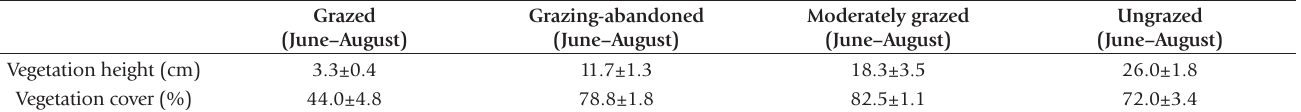
Fig. 3. PCoA ordination (sum of all eigenvalues: 20.008, similarity index: correlation) based on Orthoptera data. The different years are marked by A, B, C, D and E ( A : 2012, B : 2013, C : 2014, D : 2015 and E : 2016; e.g. 1-A : site 1 in 2012, 2-B : site 2 in 2013, C- C: control site in 2014). Table 1. Main vegetation characteristics of the sampling sites (mean values (±SE) of the measured data in June, July and